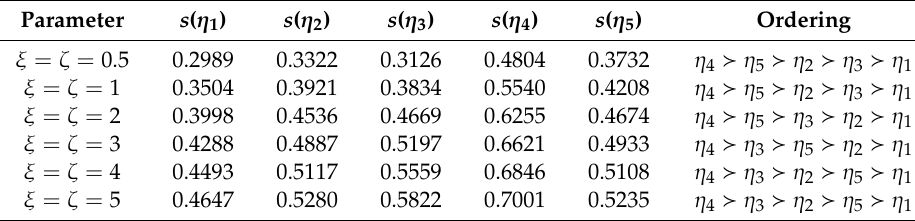
Table 2. Ordering by the DHPFGWHM operators.